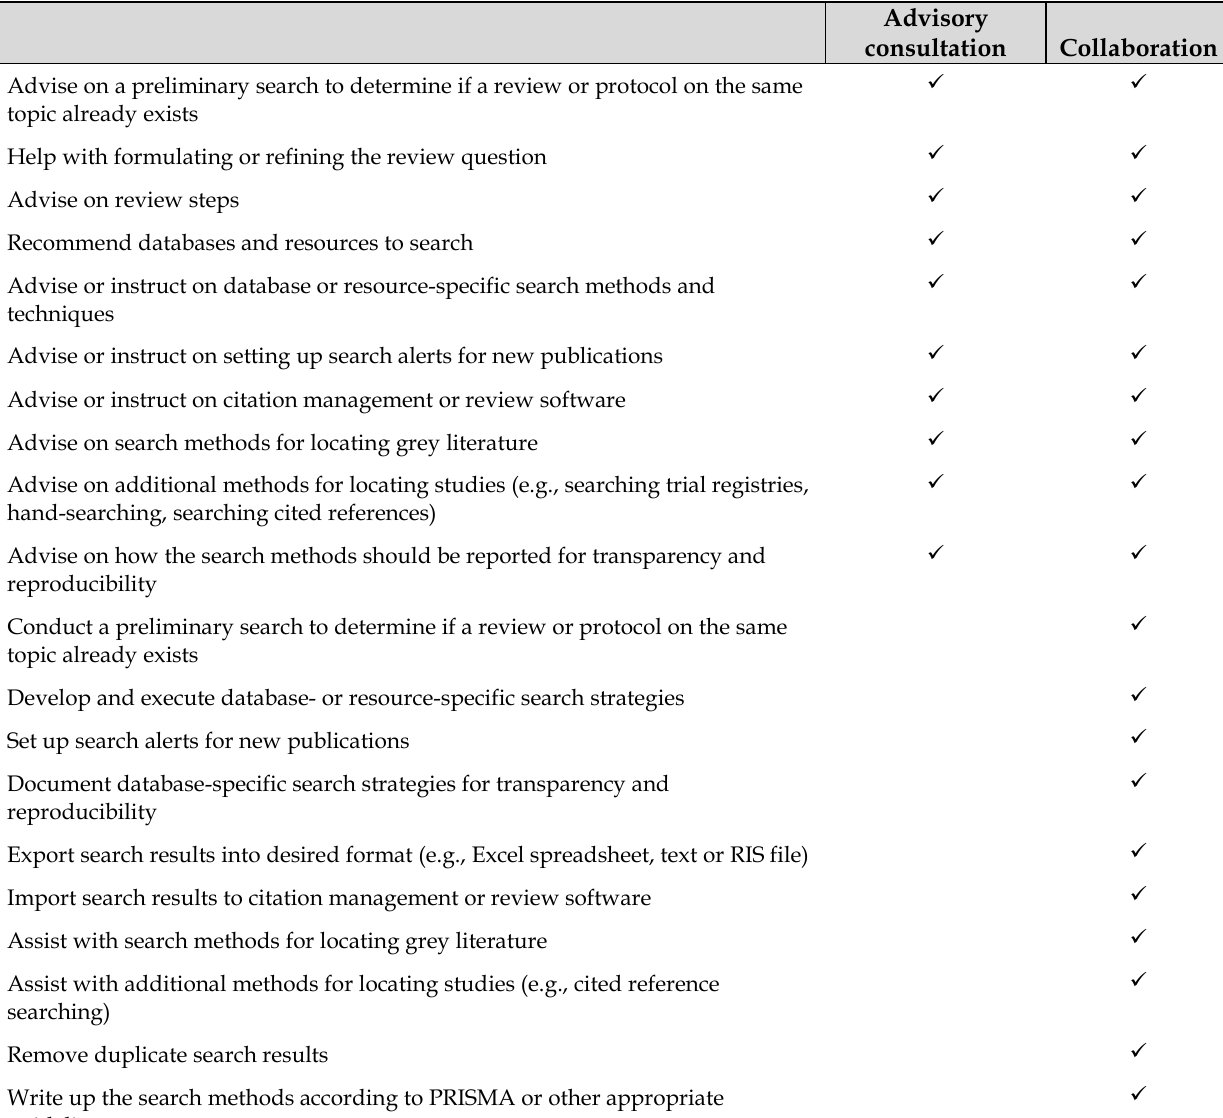
Table 1 Librarian activities involved in advisory consultation and